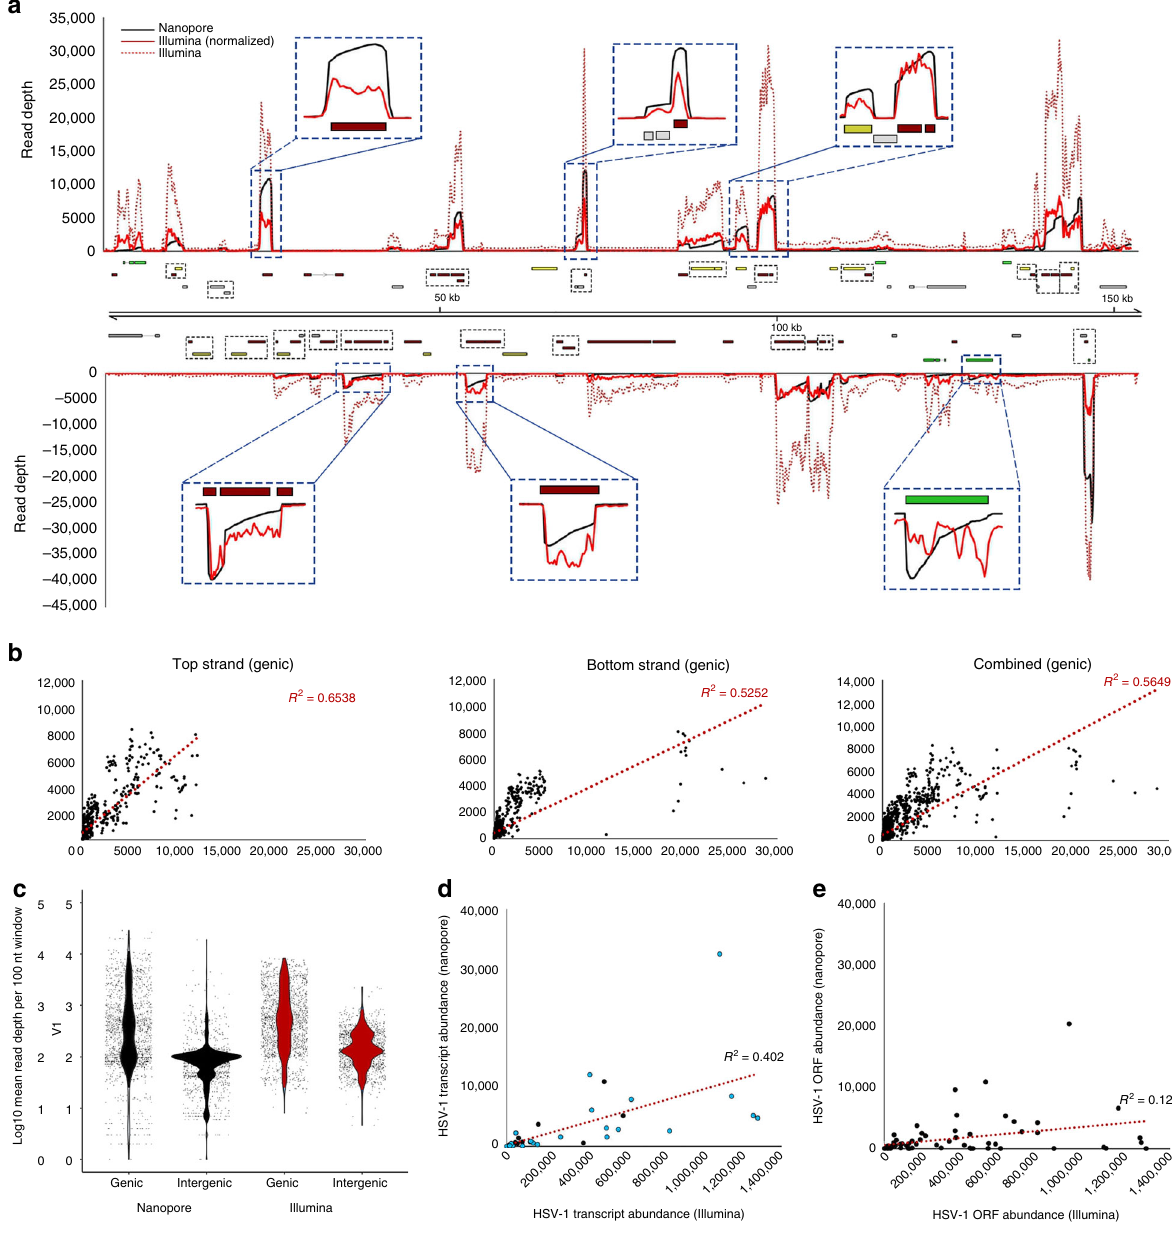
Fig. 2 Comparison of direct RNA nanopore sequencing to Illumina sequencing. a HSV-1 genome-wide sliding-window (100 nt) coverage plots of poly(A) RNA sequenced by nanopore (black) and Illumina (red) technologies. Nanopore reads represent a single polyadenylated RNA, directly sequenced, while Illumina reads are derived from highly fragmented poly(A)-selected RNAs. Illumina data (red dotted line) were normalized (red solid line) to produce the same overall coverage as the nanopore data. The HSV-1 genome is annotated with all canonical open-reading frames (ORFs) and colored according to kinetic class (green — immediate early, yellow — early, red — late, and gray — unde fi ned). Multiple ORFs are grouped in polycistronic units and these are indicated by black hatched boxes. The y -axis represents absolute read-depth counts. Inset windows (blue hatched boxes) exemplify the 3 ′ bias inherent to direct RNA-seq (due to sequence reads being generated 3 ′ − > 5 ′ ) that is less prevalent in Illumina data. b Correlation analyses of HSV-1 genome coverage were generated using nanopore and Illumina sequence data. The sliding-window analysis was determined by calculating and plotting mean read-depth values per 100 nucleotide windows across canonically de fi ned genic regions in both a strand-speci fi c and strand-combined manner. c Dot plots denoting read- depth values (100-nt intervals) in genic and intergenic regions for both direct RNA-seq and normalized Illumina datasets. Read depths between genic and intergenic regions differ by a mean fold difference of 12.08 (nanopore) and 6.82 (Illumina). The y -axis is log-10 scaled. d , e Transcript abundances were counted for nanopore and Illumina datasets by aligning against two versions of the HSV-1 transcriptome. The simpli fi ed version (left) collapses polycistronic units into simple transcription units, while the standard version (right) comprises all individual coding units, whether mono- or